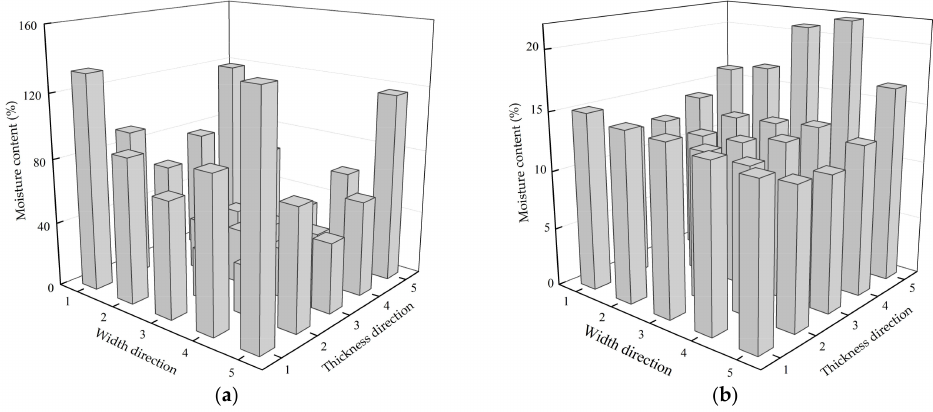
Figure 10. The moisture content distribution map inside sample. ( a ) Moisture content 65%; ( b ) Moisture content